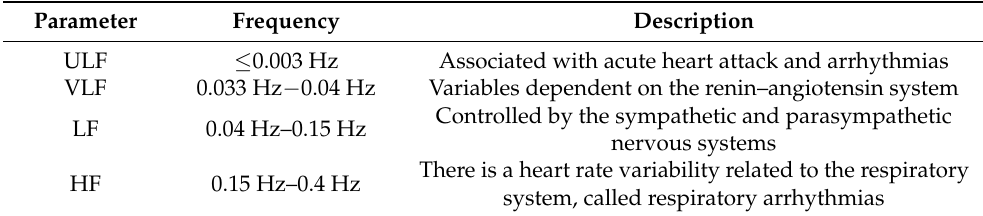
Table 5. Disease information according to frequency band.